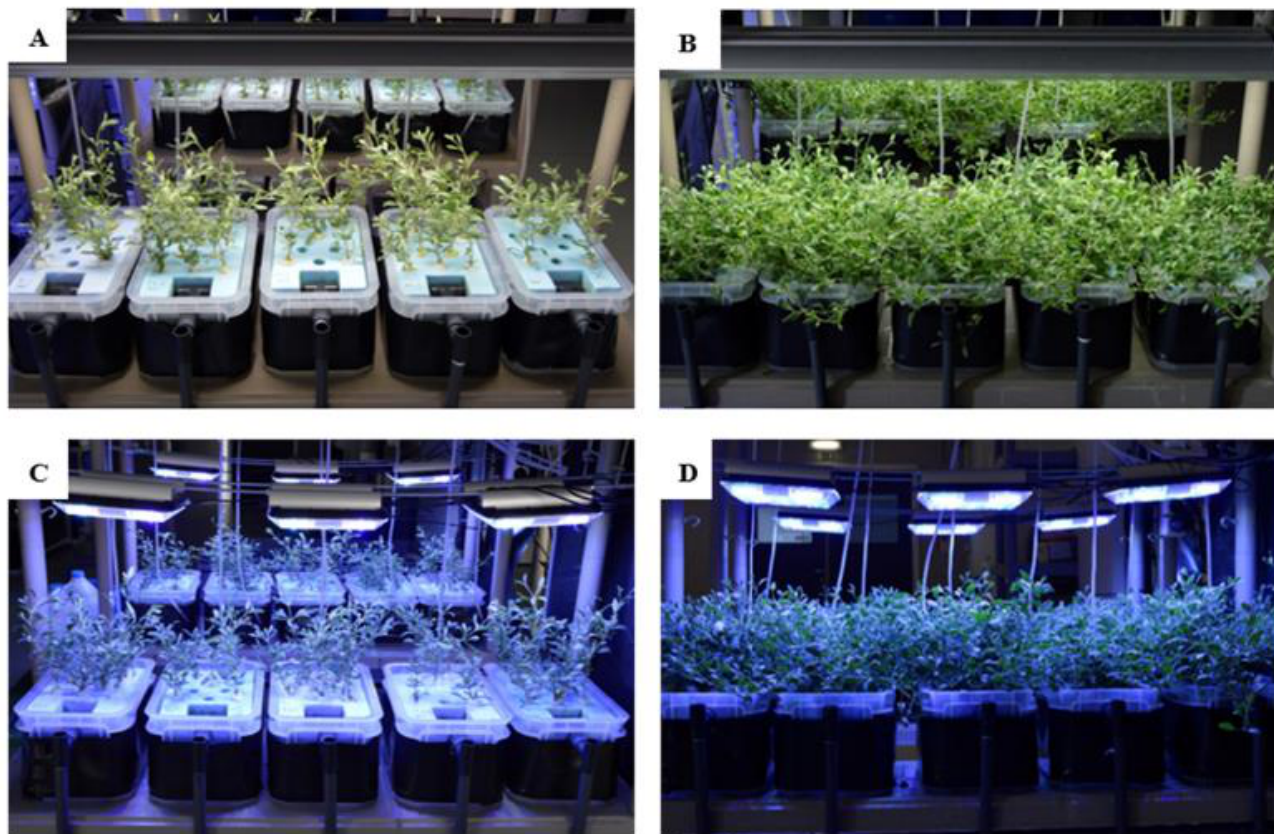
Figure 1. Experimental units illuminated with fluorescent lights at week 1 ( A ) and week 9 ( B ) & with blue-white LEDs at week 1 ( C ) and week 9 ( D ).